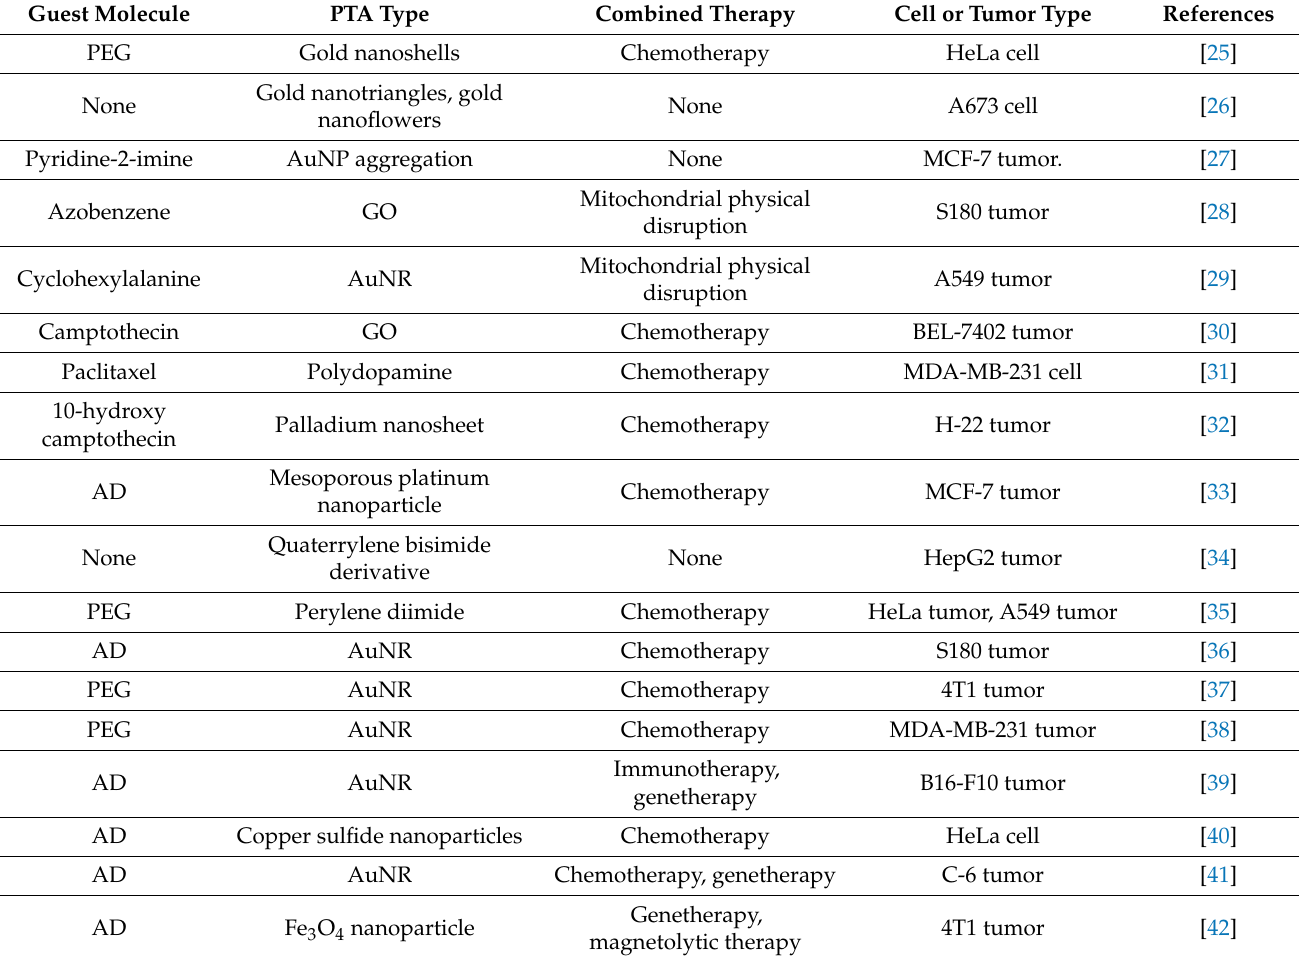
Table 1. A summary of the CD-based PTT